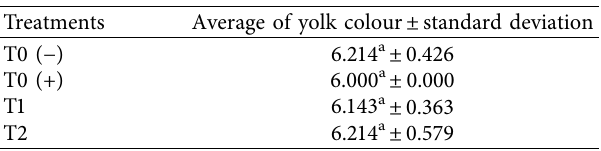
Table 5: Average of yolk colour in quails ( Coturnix coturnix japonica